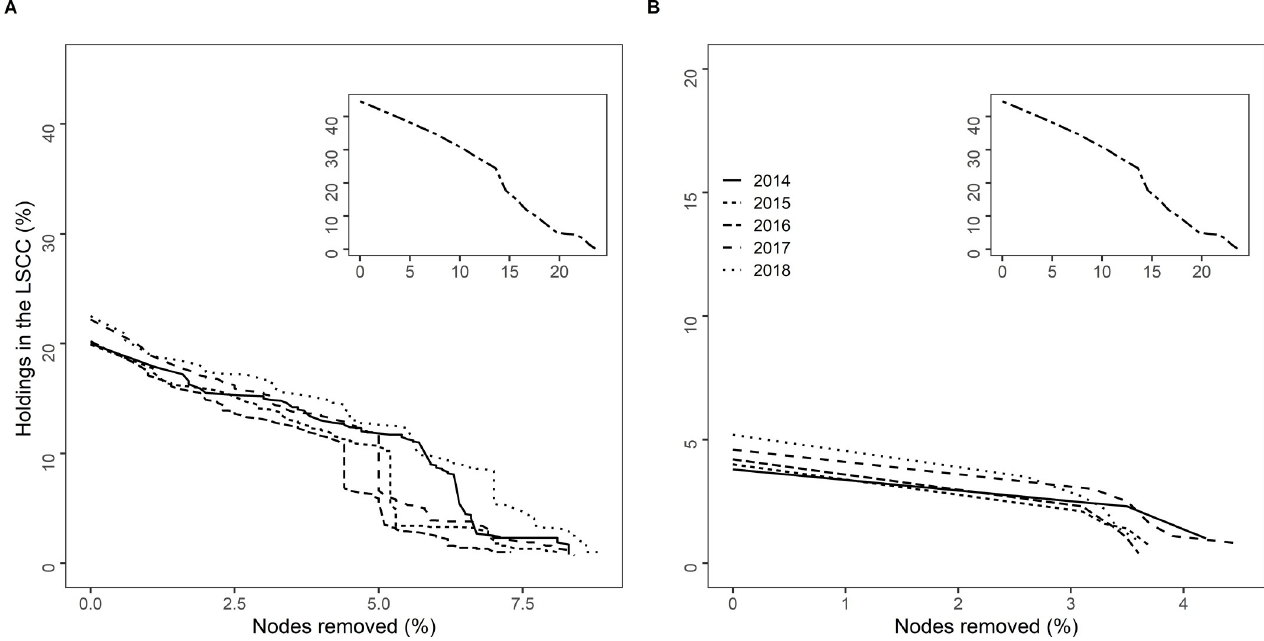
Fig 9. Percolation results for the global (inset) and annual networks (main graphs). (A): all cattle, (B): only cows in Paraguay.